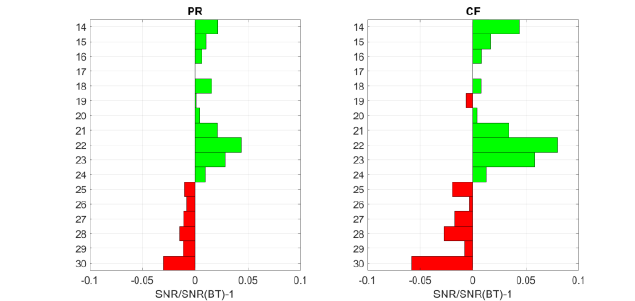
Fig. 10. Final state of the upper part of the fuel rod deduced from the hodoscope’s detectors (rows 14 to